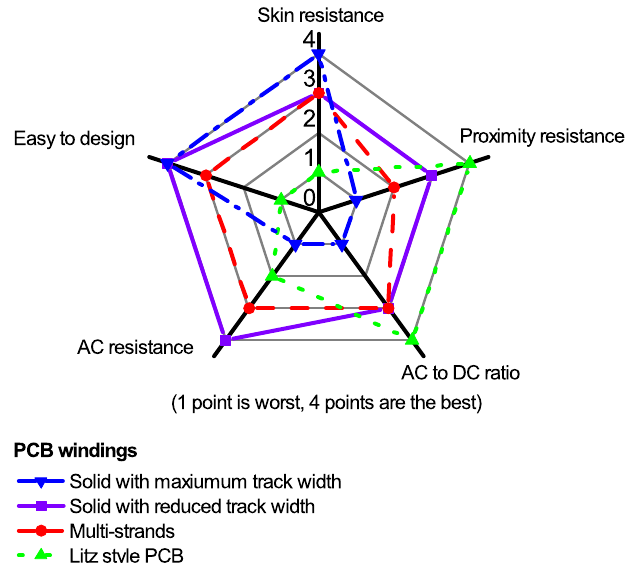
Figure 22. Comparison among PCB winding design methods with high impact of proximity